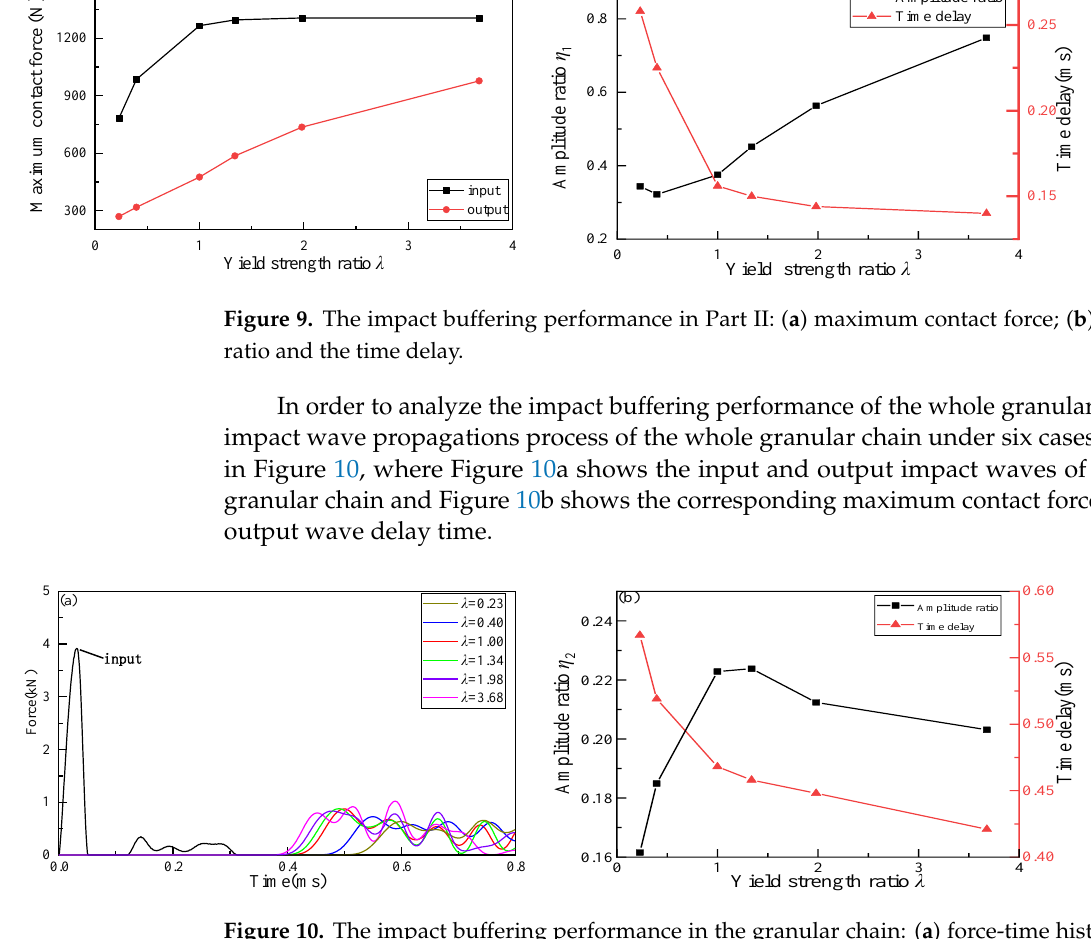
Figure 10. The impact buffering performance in the granular chain: ( a ) force-time history; ( b ) the energy dissipation and time delays.